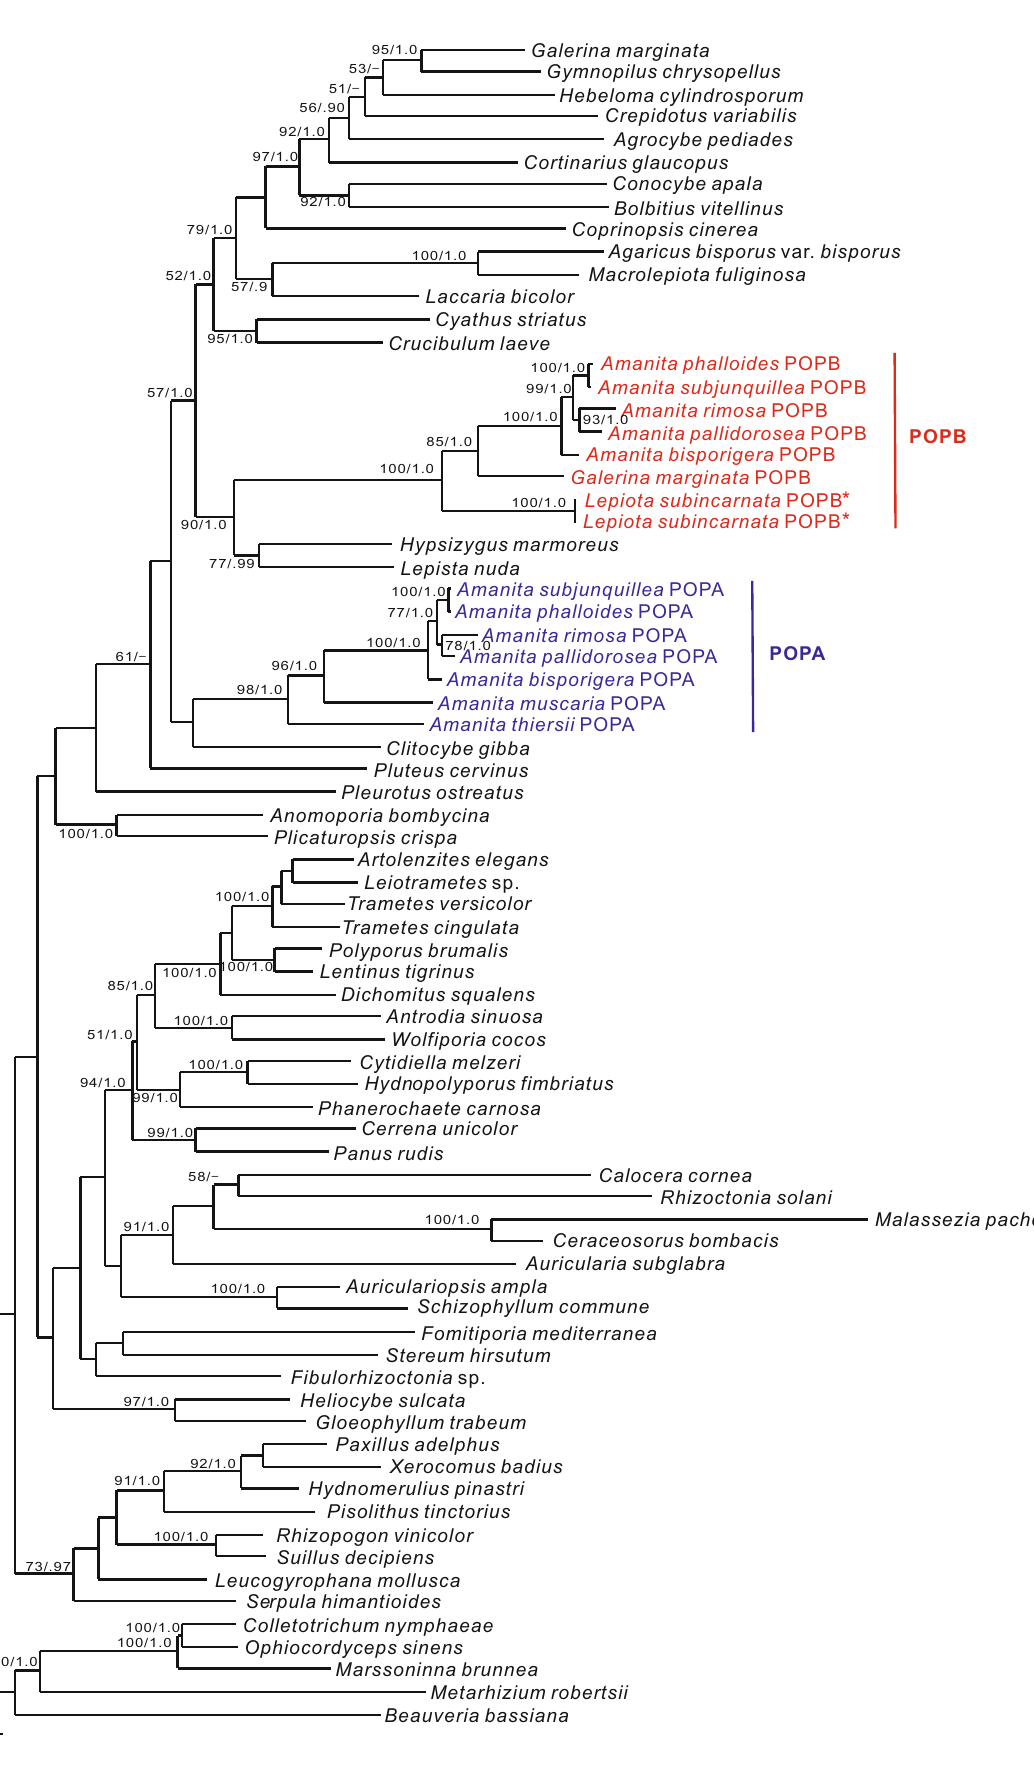
Fig. 4. Phylogeny of macrofungi inferred from maximum likelihood (ML) analysis based on coding sequences of POP gene . Maximum